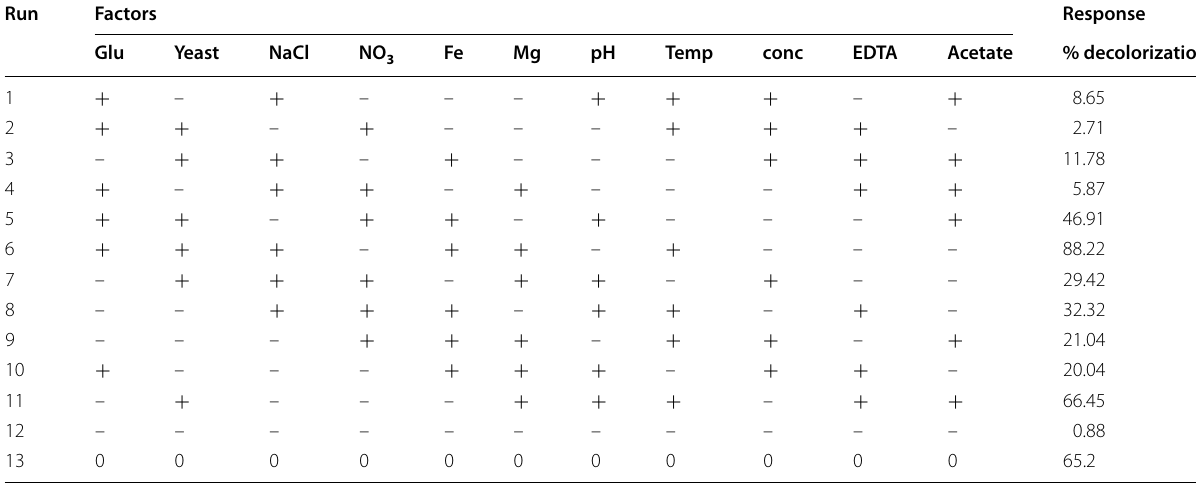
Table 2 The Placket–Burman design matrix representing the coded values for independent factors and values of meas- ured